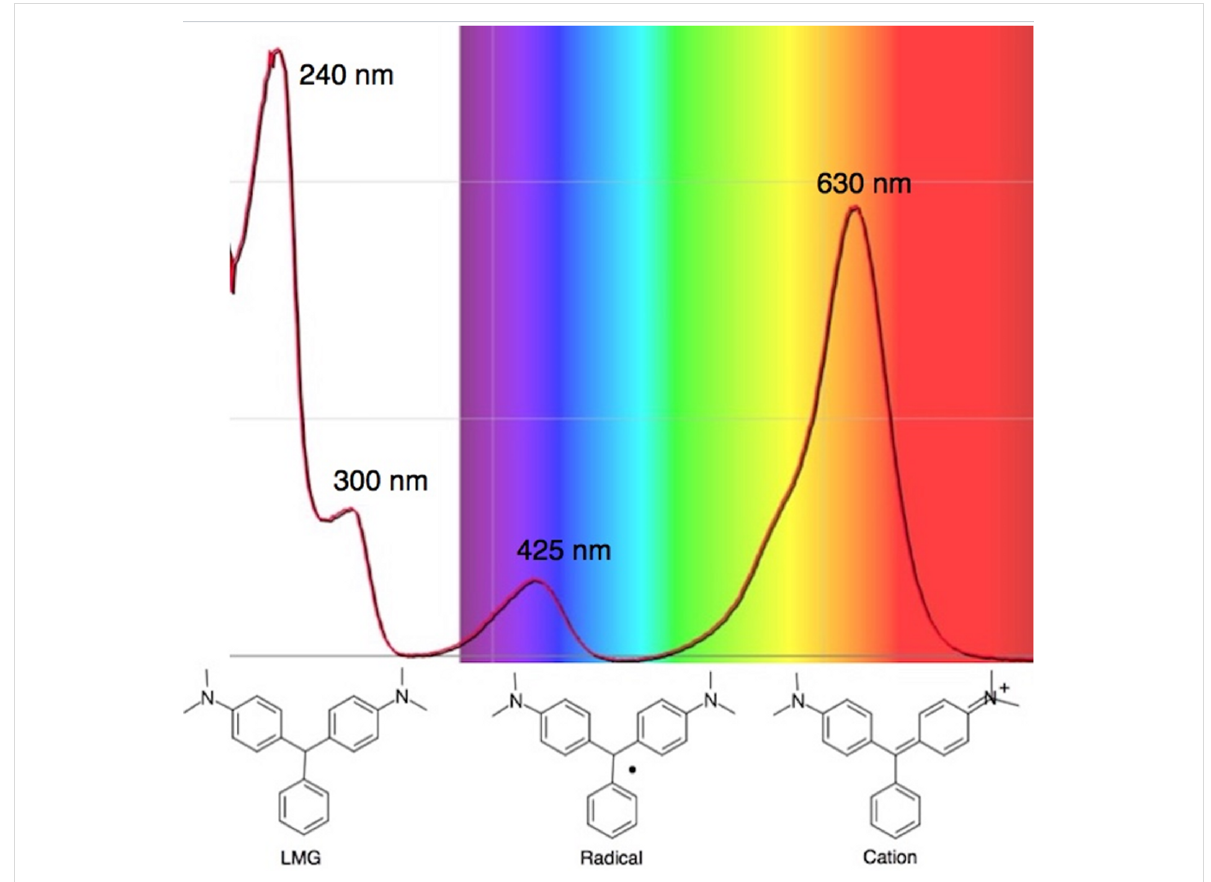
Figure 3: Absorption spectrum of irradiated leucomalachite green.